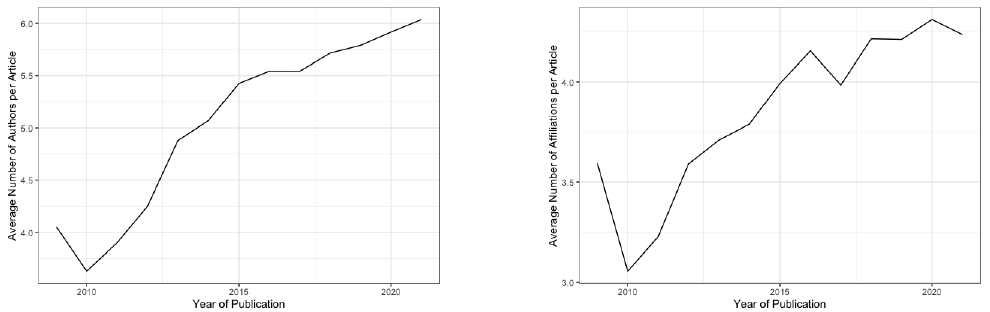
Figure 13. Average numbers of authors ( left ) and average numbers of affiliations ( right ) for articles published in Remote Sensing from 2009 to